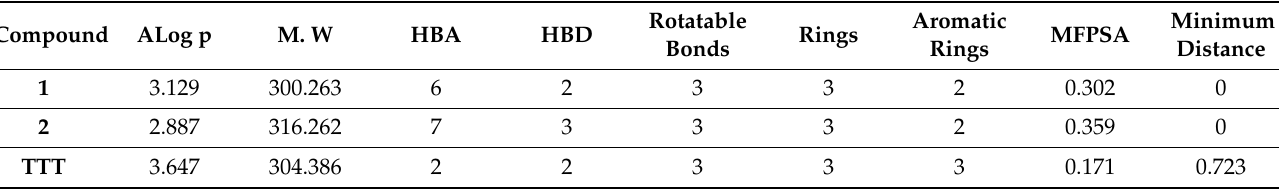
Table 1. Structural properties of compounds 1 , 2 and TTT